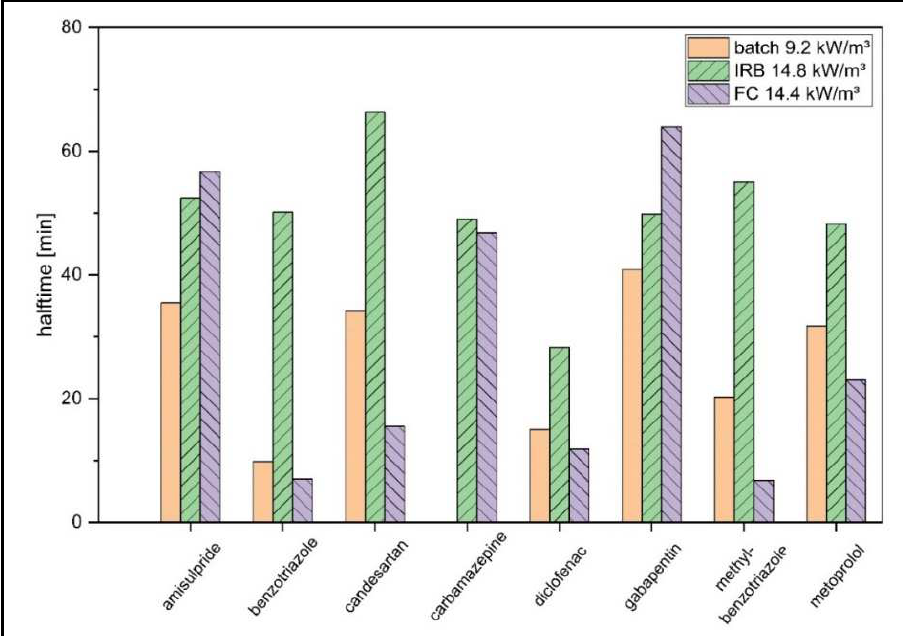
Figure 6. Halftime constants for the degradation of micro-pollutants within batch, flat cell (FC), and immersion rotary body reactor (IRB) with similar electrical irradiation powers of 9.2 to 1483 kW/m³.